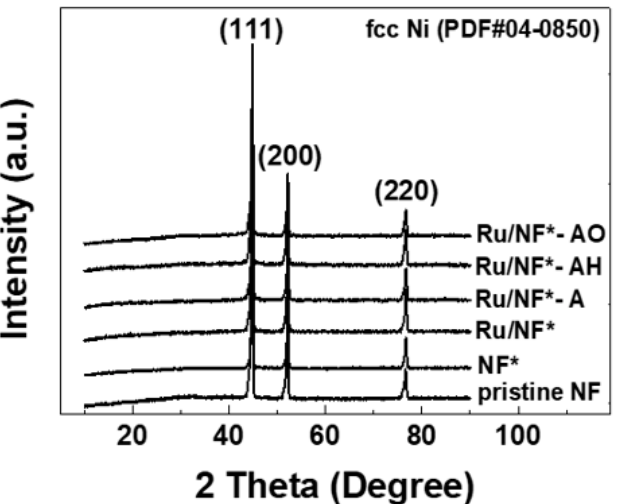
Figure 3. XRD patterns of the pristine NF, NF*, Ru/NF*, Ru/NF*-A, Ru/NF*-AH, and Ru/NF*-AO.